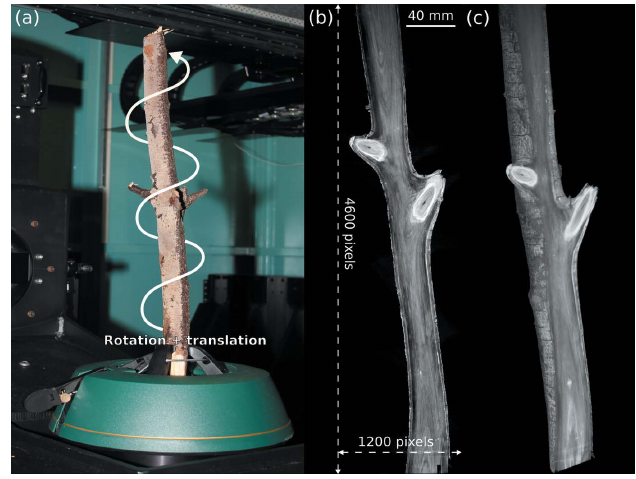
Figure 8 Helical cone beam tomography of a tree branch. Experimental setup ( a ); a slice through the reconstructed volume ( b ); 3D volume rendering ( c ). Total volume size was 2048 (cid:5) 2048 (cid:5) 5217 with voxel size 82.35 m m (cid:5) 82.35 m m (cid:5) 82.35 m